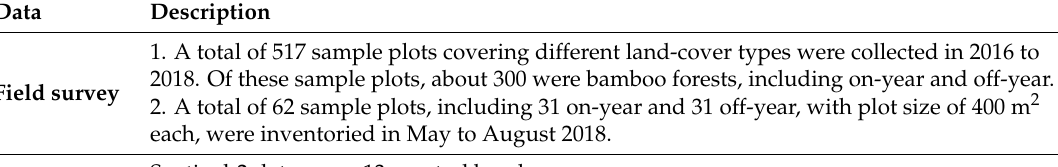
Table 1. Data used in